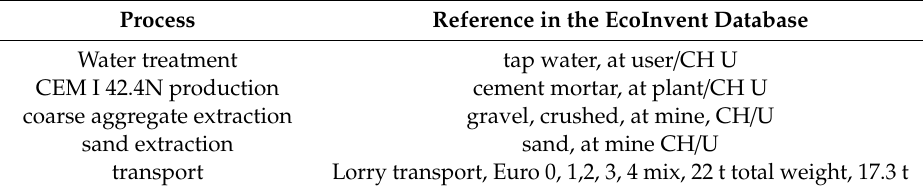
Table 3. Processes included in the cradle-to-gate life-cycle assessment (LCA) of the concretes and the corresponding references in the EcoInvent v3.5 database